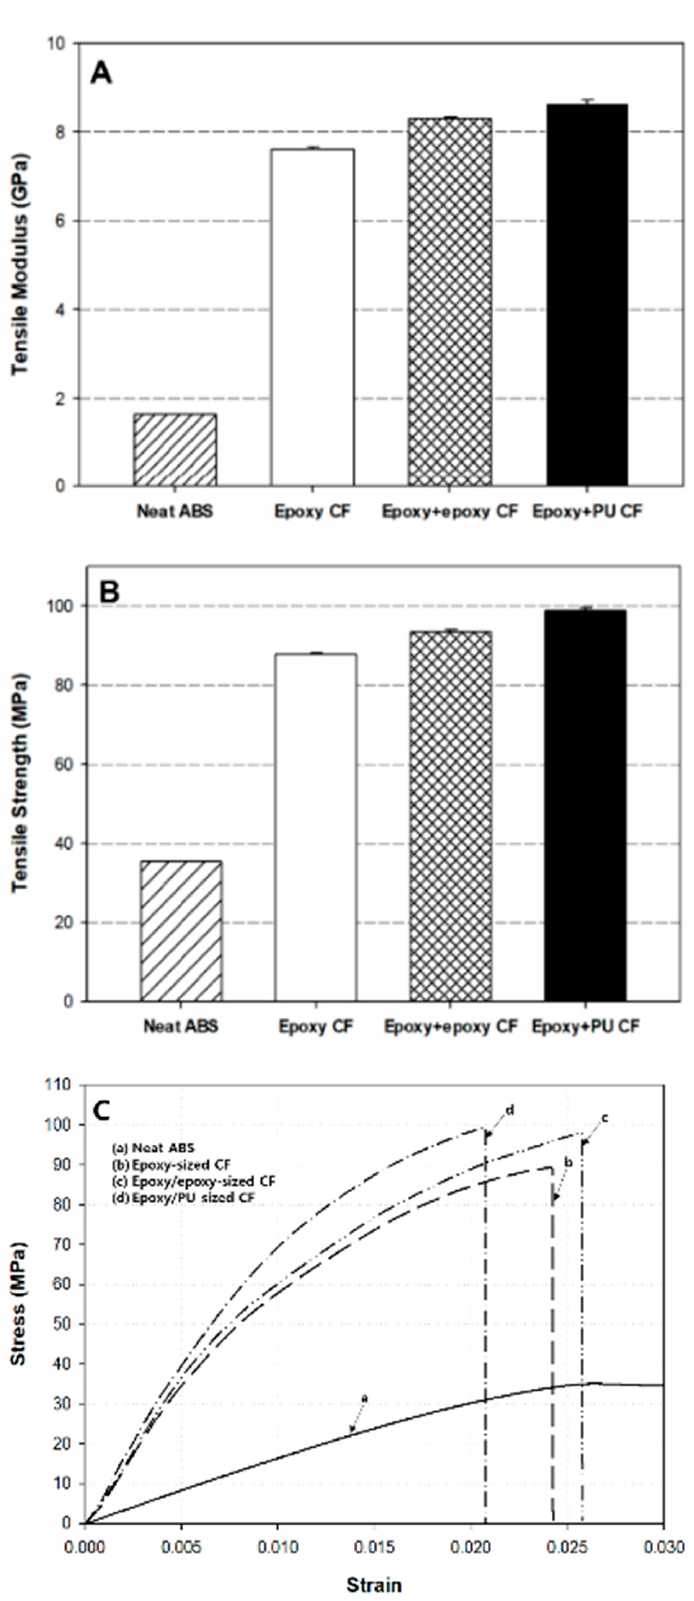
Figure 8. Comparisons of the ( A ) tensile modulus, ( B ) strength, and ( C ) stress-strain curves of neat ABS and carbon fiber/ABS composites with (epoxy) single-sized and (epoxy + epoxy, epoxy + PU) dual-sized carbon fibers.